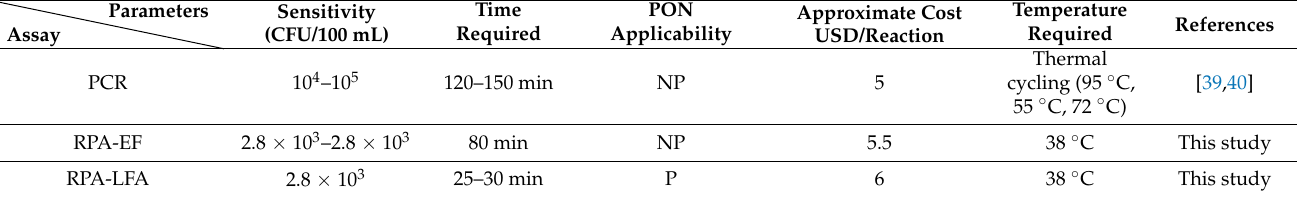
Table 4. A comparison between PCR, RPA-AGE and RPA-LFA for detection of E. faecalis .